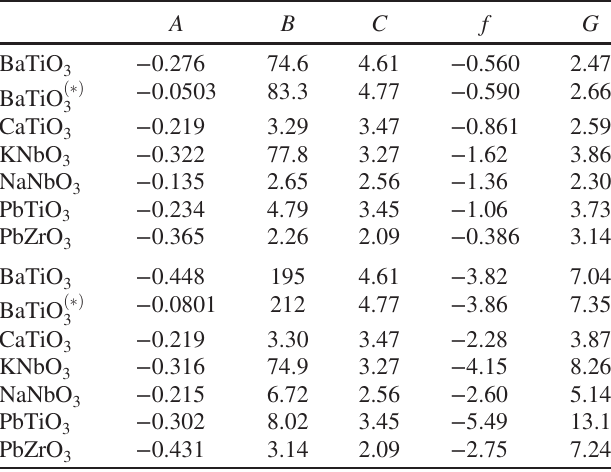
FIG. 4. Value of the elastic displacement field as a function of distance to the domain wall, for three perovskite oxides. The lines correspond to Landau model predictions using unit weights (broken lines) or atomic weights (continuous lines). The symbols correspond to local center-of-mass calculations computed with full DFT, for different cells centered on A O or B O 2 layers, and for those two